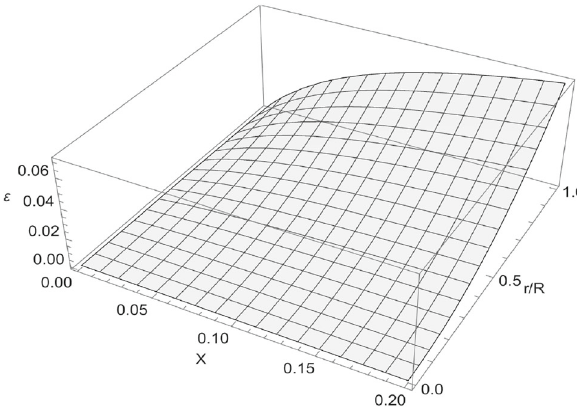
Fig. 1 Relative error from Eq. (3.20) for q V =